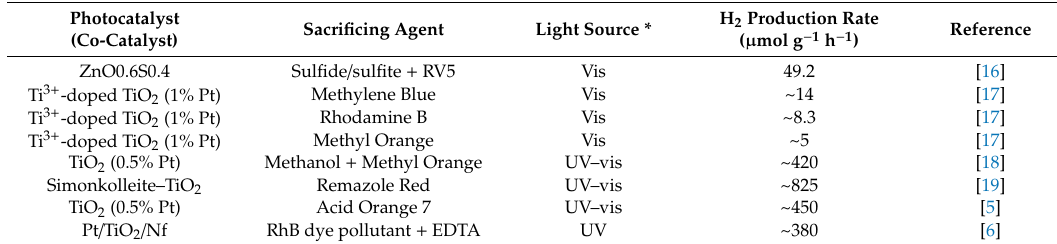
Table 1. Comparison of hydrogen production from the data of other literature with di ff erent